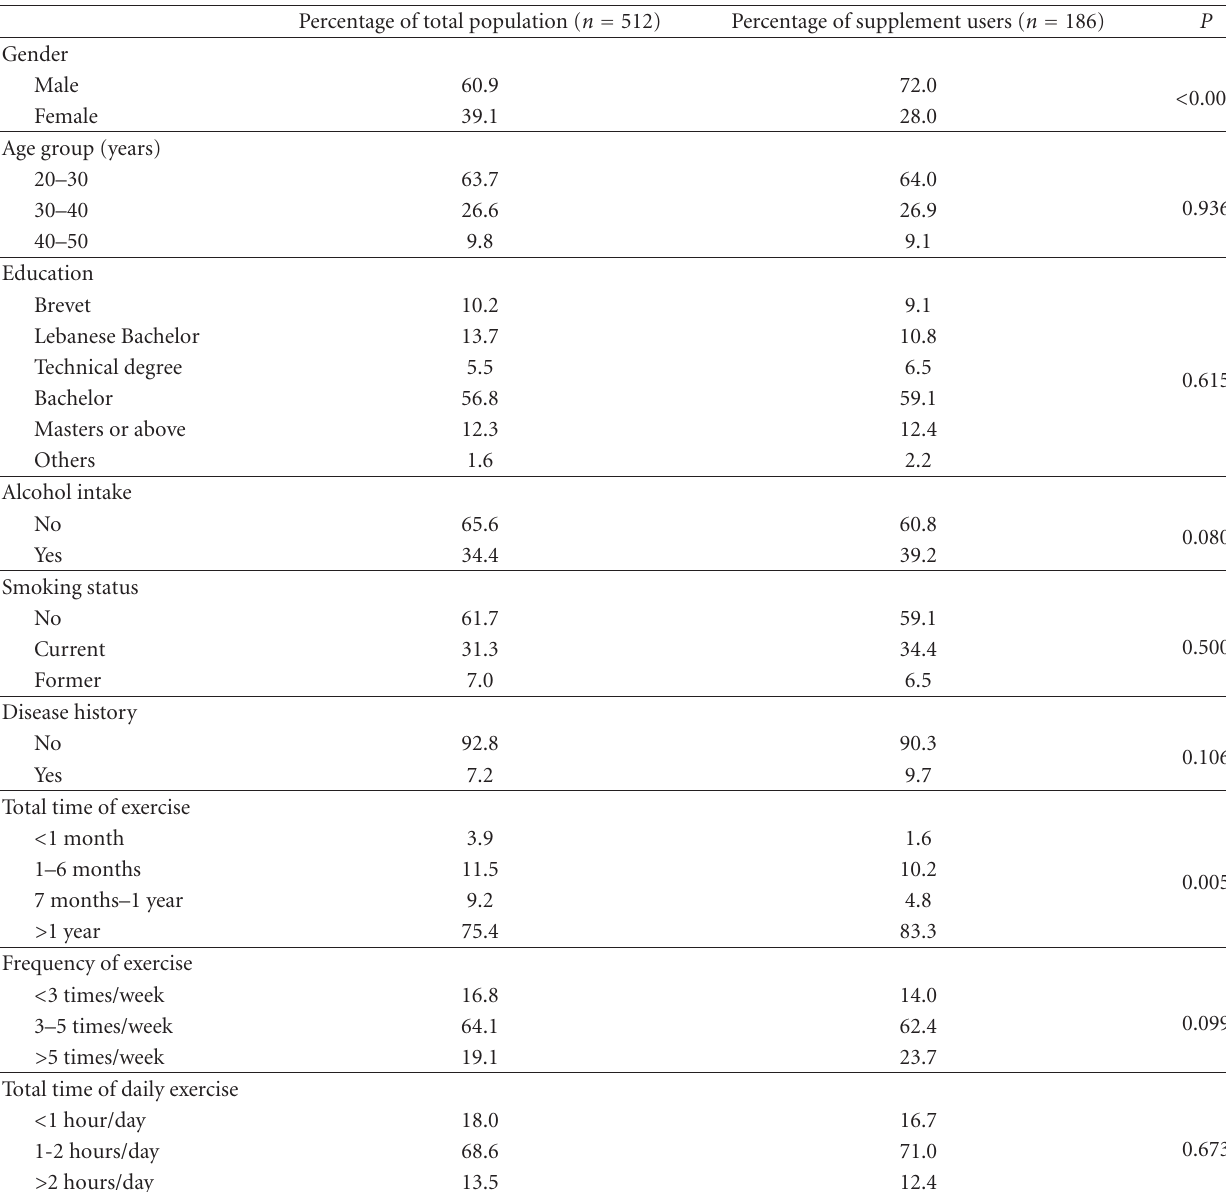
Table 1: Sociodemographic and lifestyle characteristics of all participants and of users of nutritional supplements. No missing